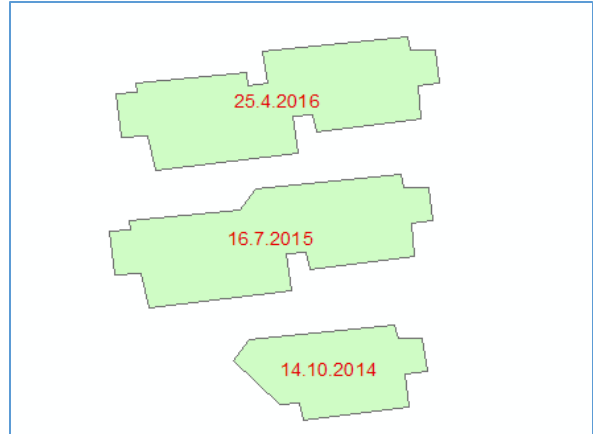
Figure 5. Temporal changes in “BUYUKBINA (building) feature class